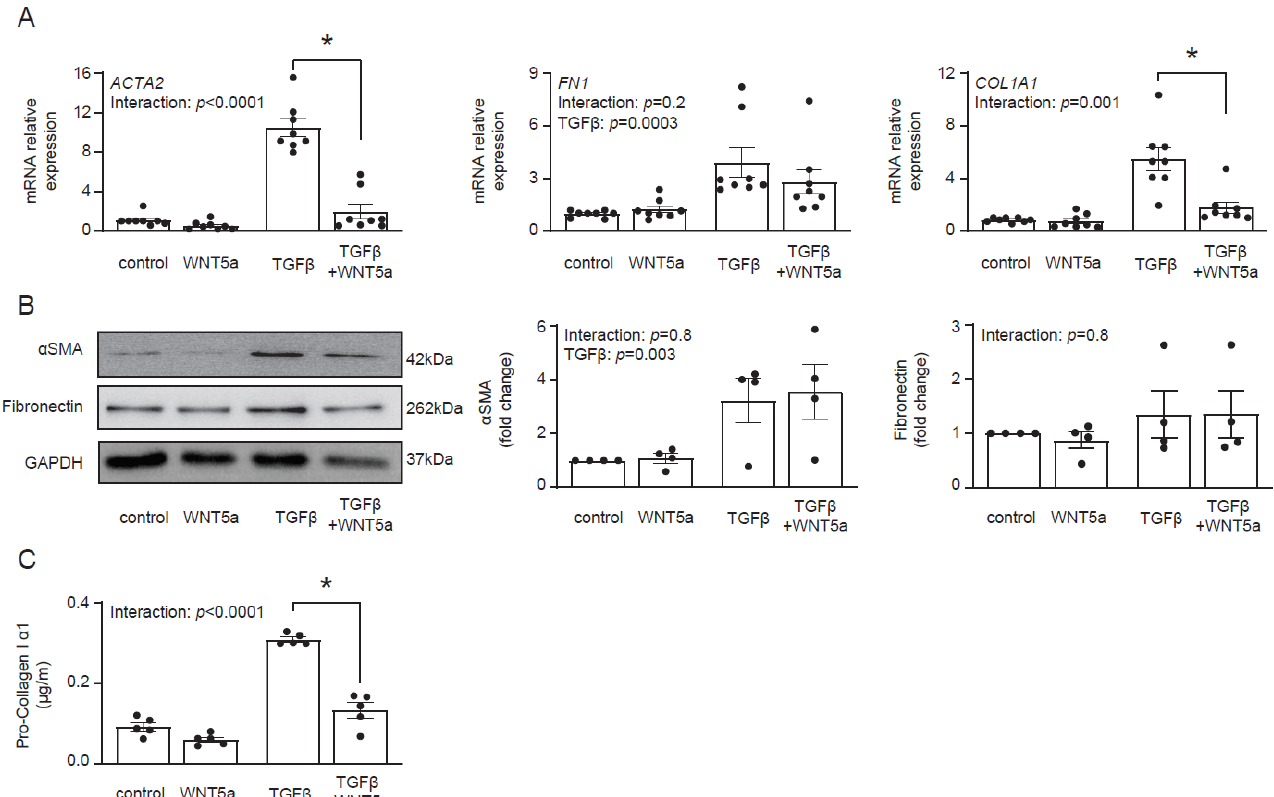
Figure 4. WNT5a reverses profibrotic response of TGF- β -activated cardiac fibroblasts. Panel ( A ) shows expression of profibrotic genes ( n = 8) and panel ( B ) illustrates representative immunoblots with the respective quantifications of α SMA ( n = 4) and fibronectin ( n = 4) in cardiac fibroblasts stimulated with WNT5a and/or TGF- β for 72 h. Panel ( C ) shows pro-collagen I α 1 levels measured in supernatants of cardiac fibroblasts treated as indicated for 5 days ( n = 5). Bars and whiskers represent means ± SEM. Main effect of WNT5a, TGF- β and their interaction were tested using two-way ANOVA followed by Tukey’s multiple comparisons test, when the p -value for interaction was < 0.05, * p < 0.05 (post-hoc TGF- β vs. TGF- β+WNT5a).